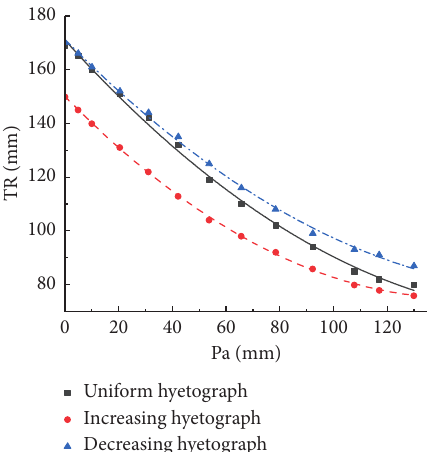
Figure 6: TR-Pa curves of TVUHs for different hyetographs.